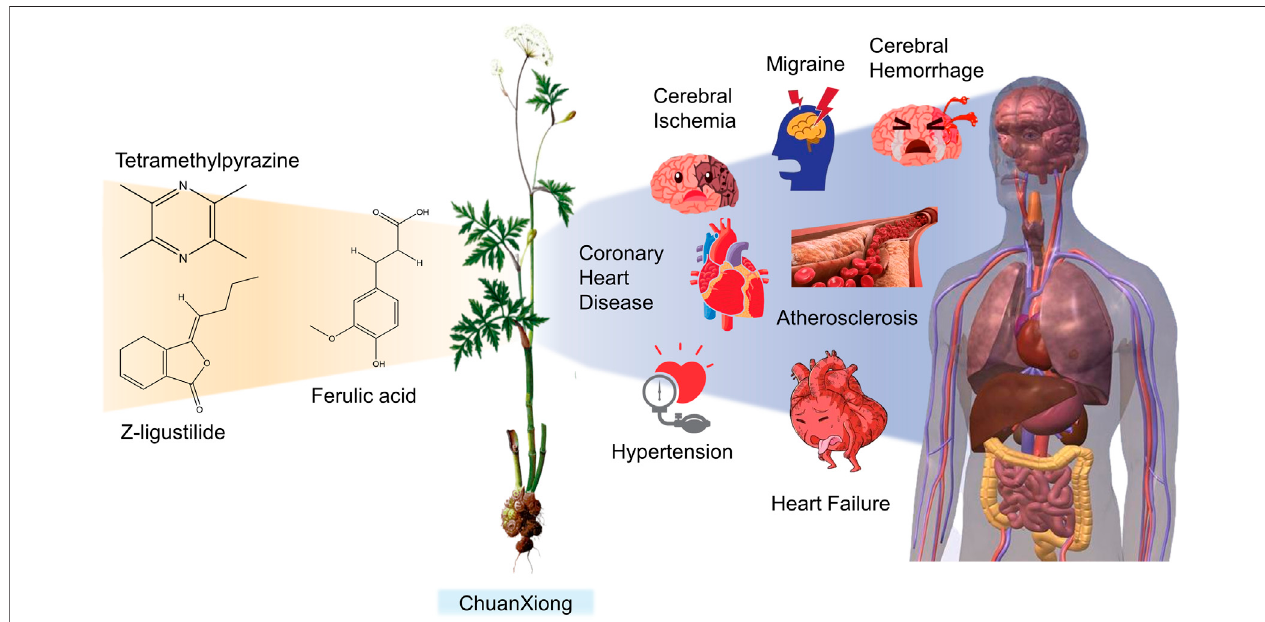
FIGURE 1 | Basic information of Ligusticum chuanxiong Hort. (CX contains tetramethylpyrazine, Z-ligustilide, ferulic acid, and other components, which are widely used in CVDs, including hypertension, CHD, AS, heart failure, cerebral ischemia, and cerebral hemorrhage).